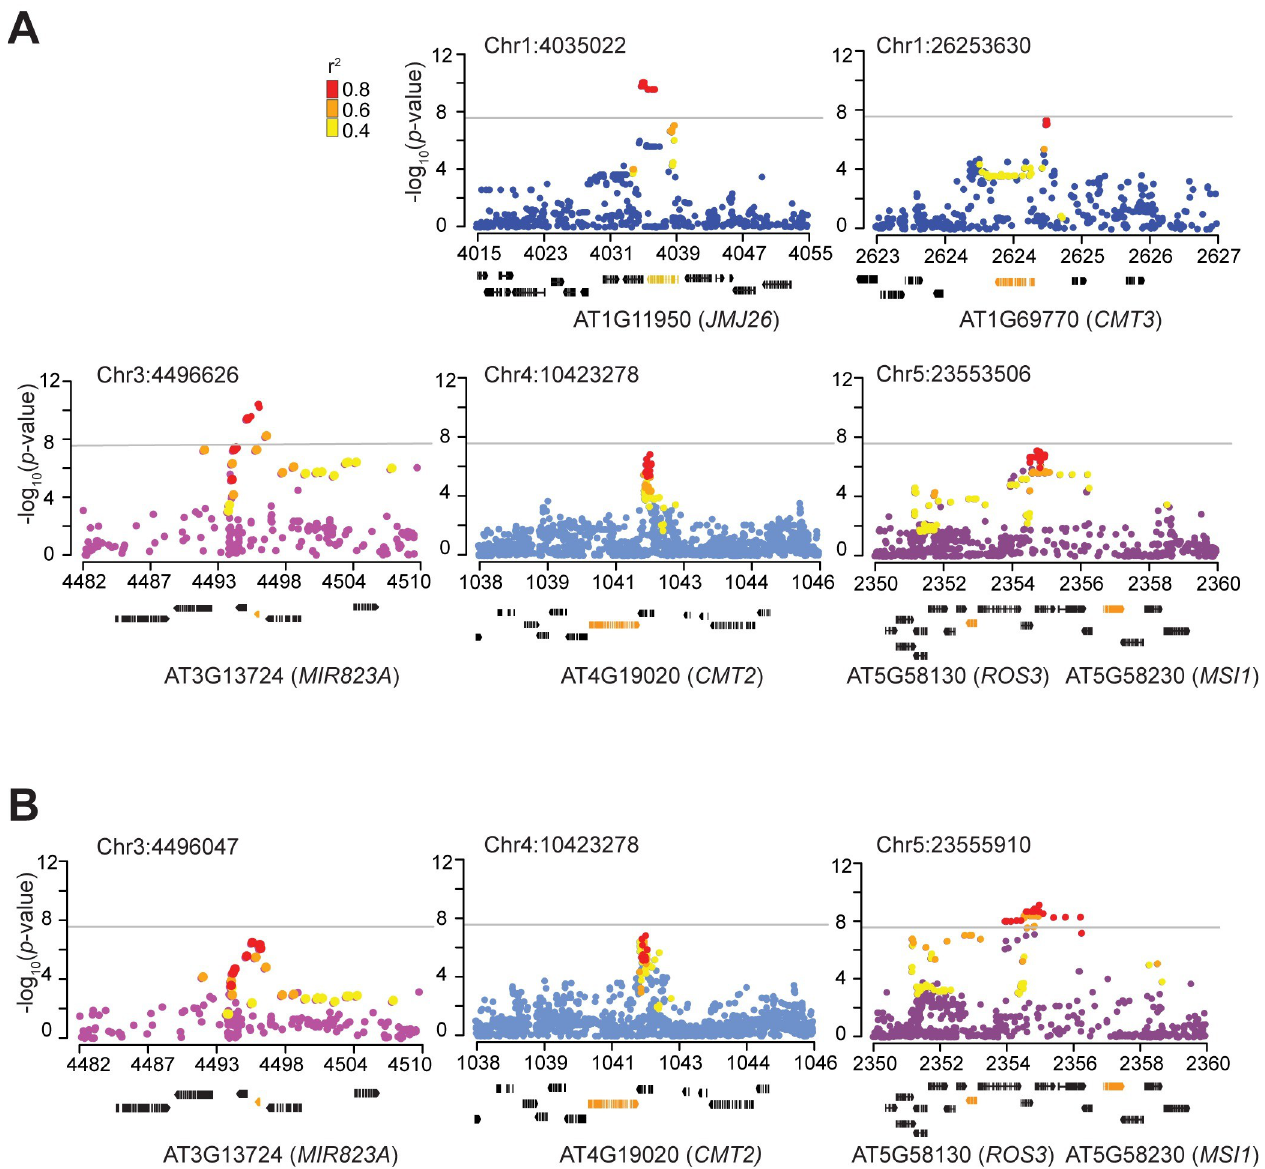
Fig 3. Candidate loci underlying mCHG |mCHH variation. Zoomed-in Manhattan plots around conditional GWAS peaks in Fig 2 for (A) RdDM- and (B) CMT2-targeted transposons. Gene models below the plots show the candidate genes in orange (see Table 1). Colored dots represent SNPs in strong linkage disequilibrium with top